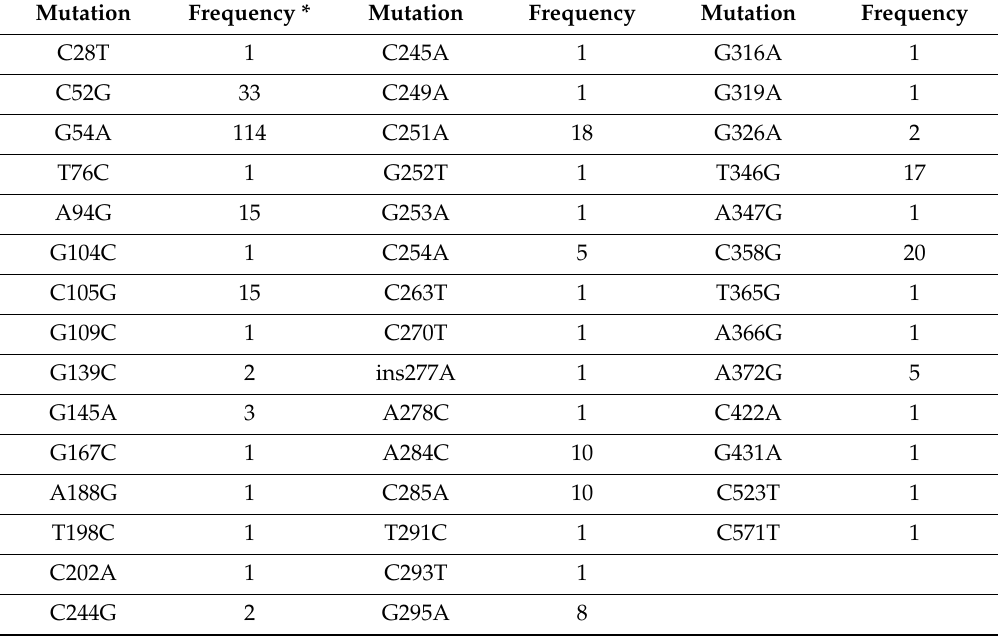
Figure 3. Mutations and their prevalence in variants of Washington University polyomavirus (WUPyV) noncoding control region (NCCR). The numbering of the NCCR is from early to late, with nucleotide being 1 the most proximal to the ATG start codon of the early genes and the most distal nucleotide, just upstream of the start codon of the VP2 gene. The number of times a peculiar mutation is found in the different variants is given as frequency (with n the number of times the mutation was described/total NCCR variant sequences available). Putative Large T antigen (LT) binding motifs 5 ′ - GRGGC-3 ′ ( → ) or 5 ′ -GCCYC-3 ′ ( ← ) are shown. The table summarizes the mutations, their location in the NCCR, and their frequency. For details see Table S1. Putative transcription factor binding sites are shown in Table S2. Table 5. Frequency of mutations in the noncoding control region of Washington University polyomavirus.